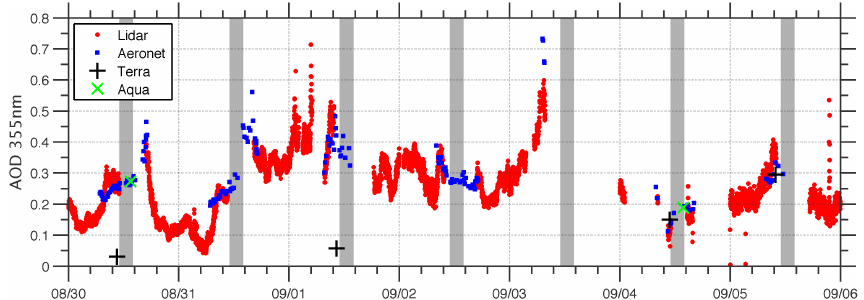
Figure 14. The time series of aerosol optical depth at 355nm obtained from the elastic inversion (red), AERONET (blue), MODIS-Terra (black) and MODIS-Aqua (green) are shown between 30 August and 6 September 2011. Gray regions correspond to local solar noon.